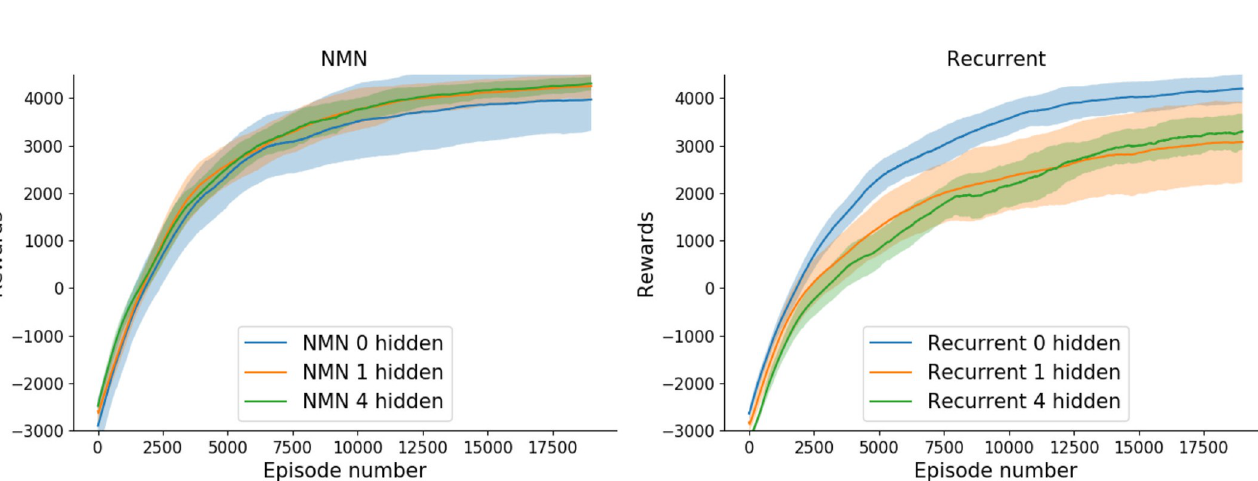
Fig 11. Mean ( ± std in shaded) sum of rewards obtained over 15 training runs with different random seeds with respect to the episode number. Results of benchmark 1, 2 and 3 are displayed from left to right. The plots are smoothed thanks to a running mean over 1000 episodes.